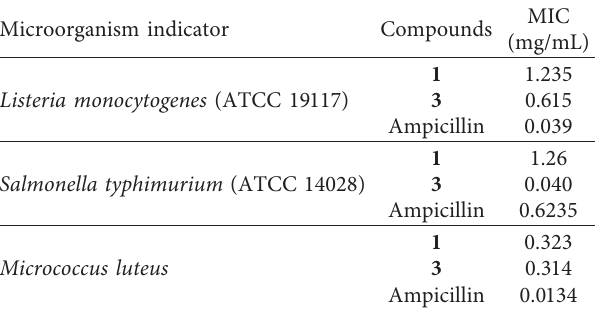
Table 2: Minimal bacterial inhibitory concentrations (MICs) of 1 , 3 , and ampicillin measured in mg/mL.